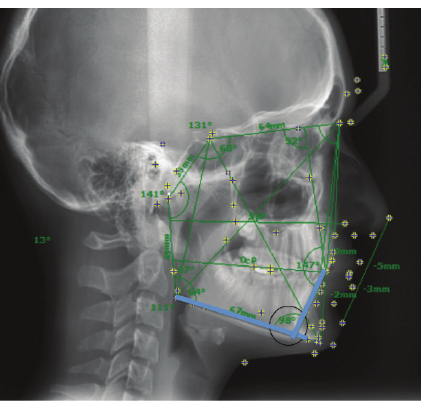
Figure 1: The degree of lower incisor inclination was measured by calculating the angle between mandibular plane (MP) and the long axis of most forward lower incisor on lateral cephalometric radiographs.